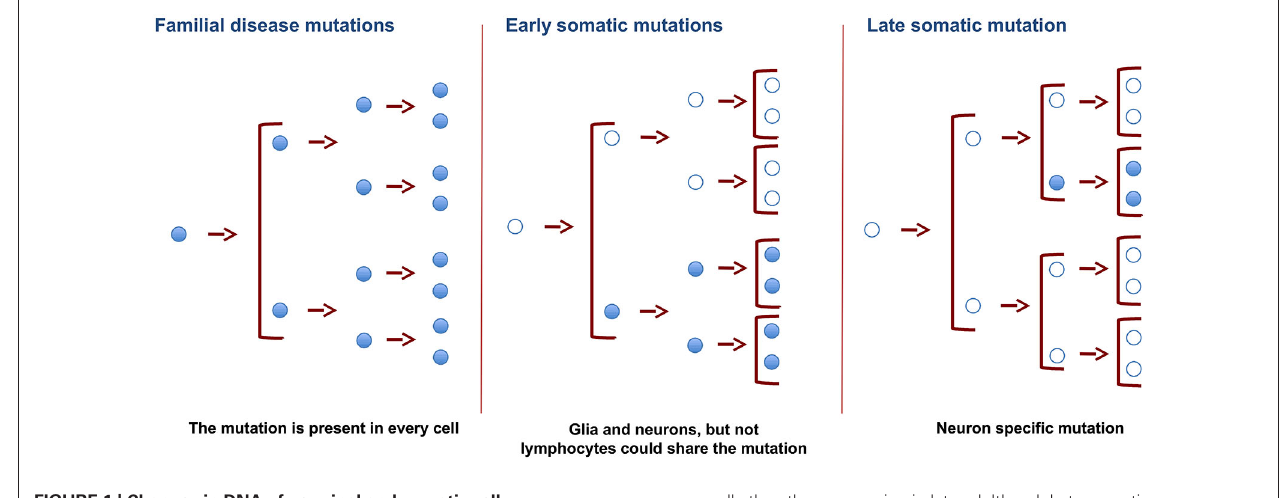
FIGURE 1 | Changes in DNA of germinal and somatic cells . SNVs in germinal cells, present in the zygote, will result in the appearance of these SNVs in all the cells of the organism. Changes resulting in SNVs at earlier developmental stages will be present in